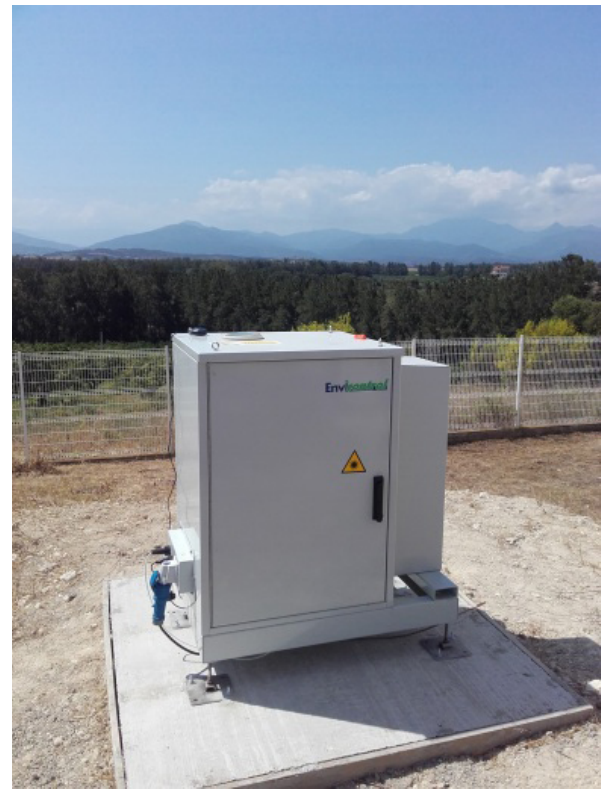
Figure 1. Mini Micro Pulse LiDAR (MiniMPL) unit from the Météo-France